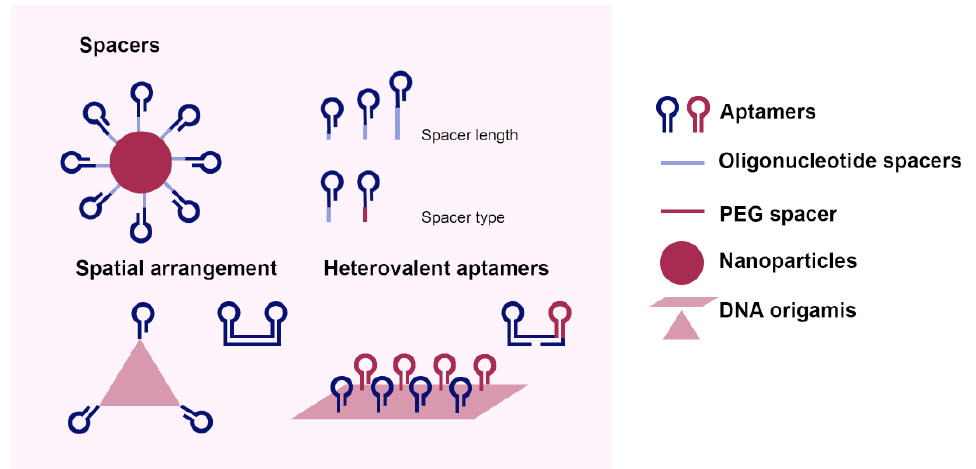
Figure 2. Schematic illustration of designs of multivalent aptamers. The optimization strategies include adding different lengths or types of spacer motifs, using a mixture of two or more different types of aptamers, and applying spatial arrangements of aptamers tailored for the geometries of target ligands and binding pockets.